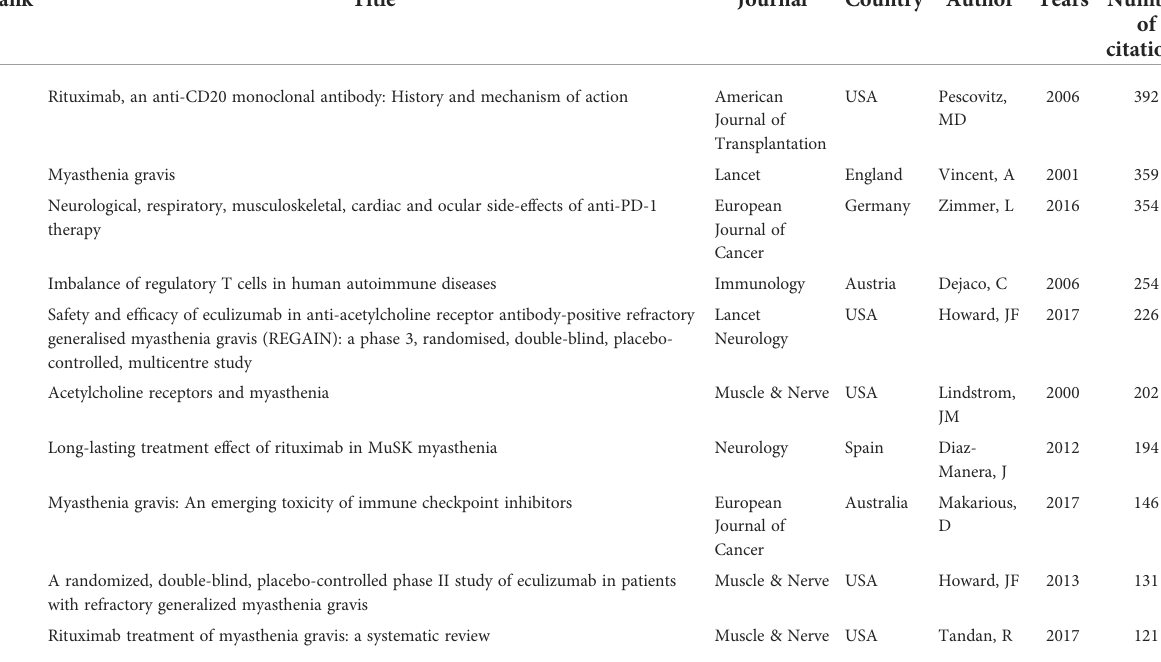
illustrated in Figure 9B, the top three keywords with the greatest number of occurrences are “ myasthenia gravis ” which appears 309 times; followed by “ rituximab ” and “ monoclonal- antibodies ” which appears 171 times and 111 times, respectively. The overlay visualization map is shown in Figure 9C, summarizing the keyword occurrences from a time zone perspective. Figure 9D. The blue line represents the time from 1998 to 2022,